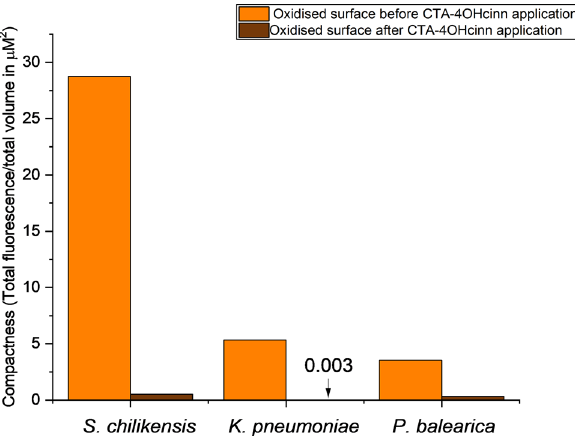
Figure 6. Biofilm compactness of oxidised surfaces expressed as total fluorescence/total volume in µM 3 of substrate surface area.